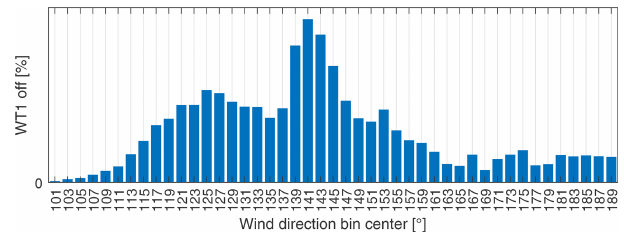
Figure 14. Probability of WT2 being in “no operation” state as a function of met-mast wind direction (using 10Hz measurements of all available